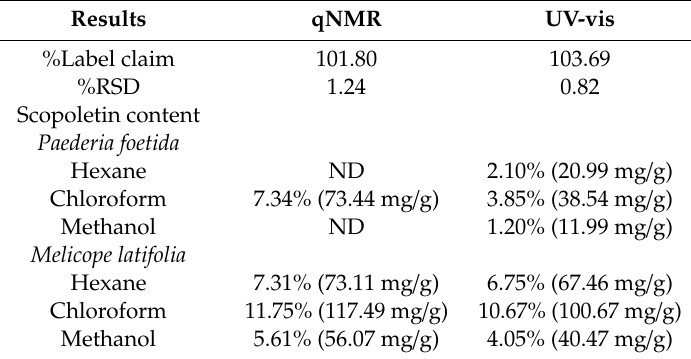
Table 12. Results of extracts using qNMR and UV–vis